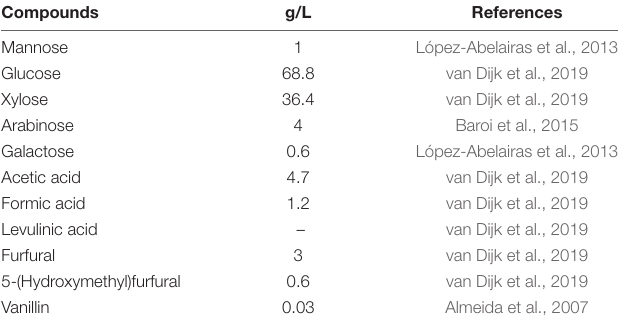
TABLE 3 | Composition of synthetic wheat-straw